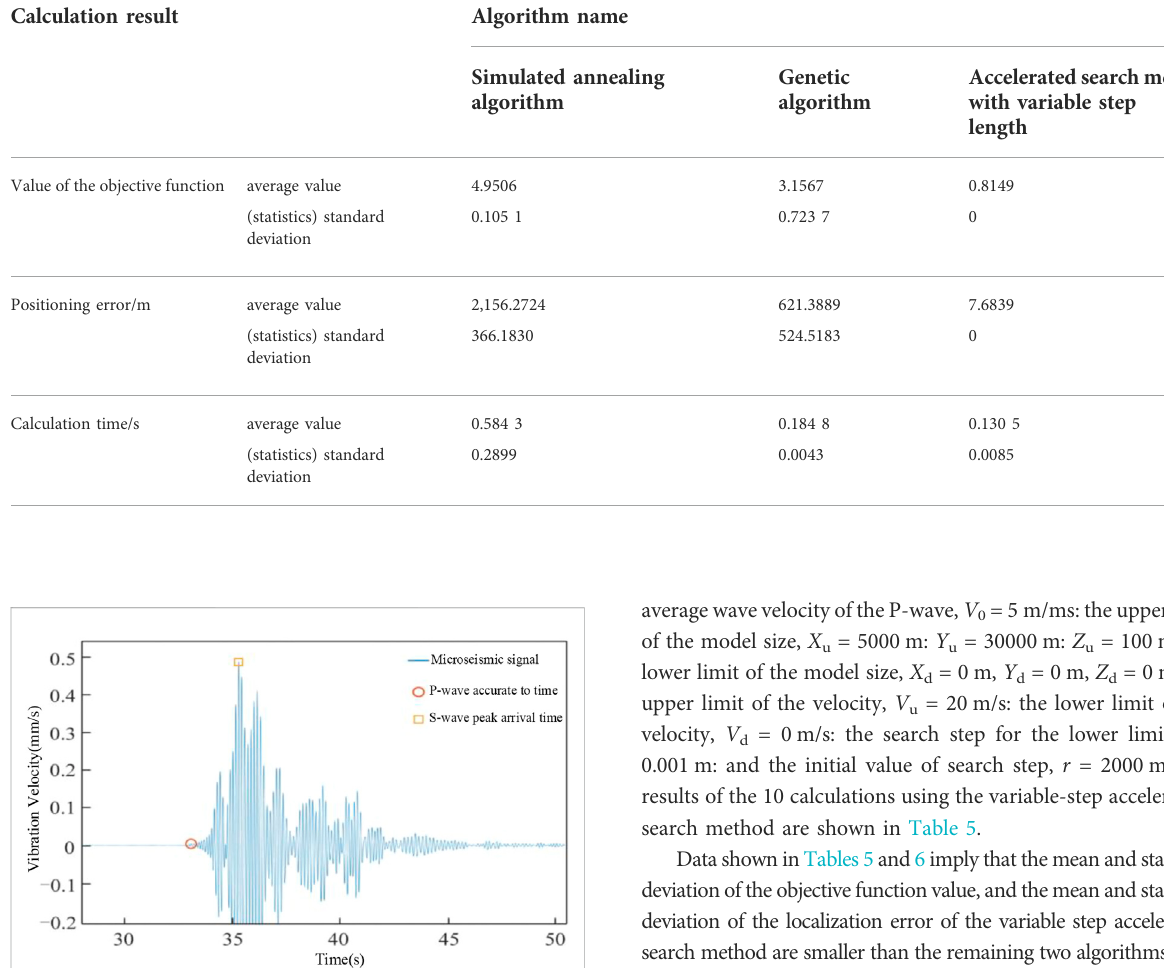
FIGURE 15 Schematic diagram of picking up mine seismic signal at arrival-time.